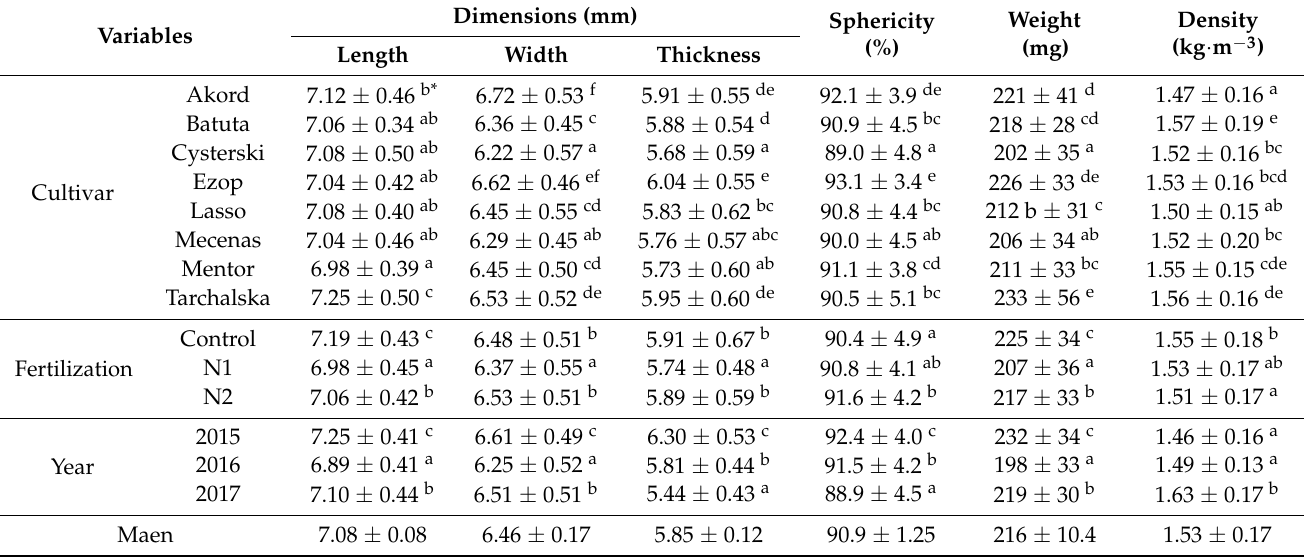
* Statistical data are expressed as means ± SD. Means in a column followed by different letters show significant differences ( p < 0.05) according to the Tukey test. A very variable distribution of meteorological conditions was observed during re- search, especially in terms of precipitation. This is confirmed by the hydrothermal index